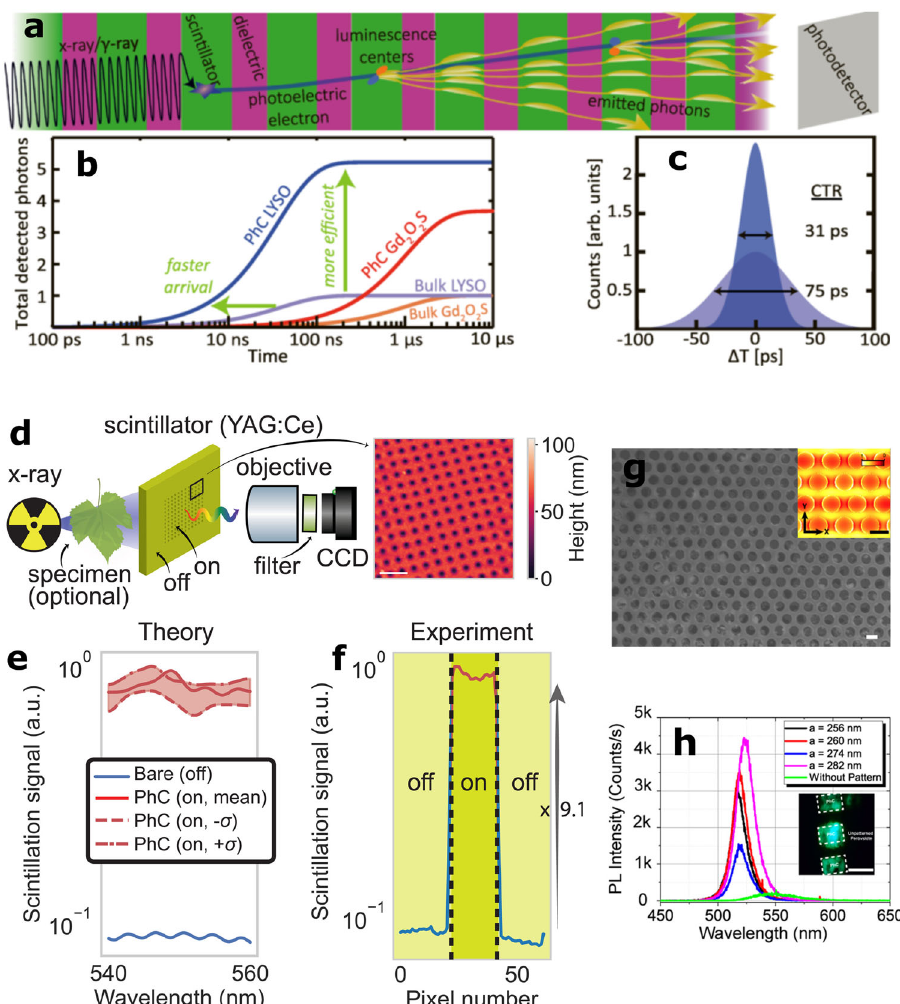
Fig. 3 Enhancement through photonic engineering. a Scintillation process of 1D photonic crystal made from the combination of scintillator material (green) with other dielectric material (pink); b number of detectable photons over time; and c coincidence time resolution (CTR) from the bulk and 1D photonic crystal scintillators. d X-ray scintillation experimental setup (left) and AFM image (right) of two-dimensional YAG:Ce photonic crystal scintillator; e calculated scintillation spectrum; and f measured scintillation along the line of the sample, including regions on (red) and off (blue) photonic crystal. g SEM image of CsPbBr 2.75 I 0.25 perovskite two-dimensional photonic crystals and a top view of the calculated electric fi eld distributions (inset); and h photoluminescence spectra of two-dimensional photonic crystals with different lattice constants and without patterns, and the sample image of photonic crystals excited by unfocused laser. ( a – c ) adapted with permission from ref. 70 , Copyright The American Physical Society, 2020; ( d – f ) adapted with permission from ref. 60 , Copyright The American Association for the Advancement of Science, 2022; ( g , h ) adapted with permission from ref. 73 , Copyright American Chemical Society,